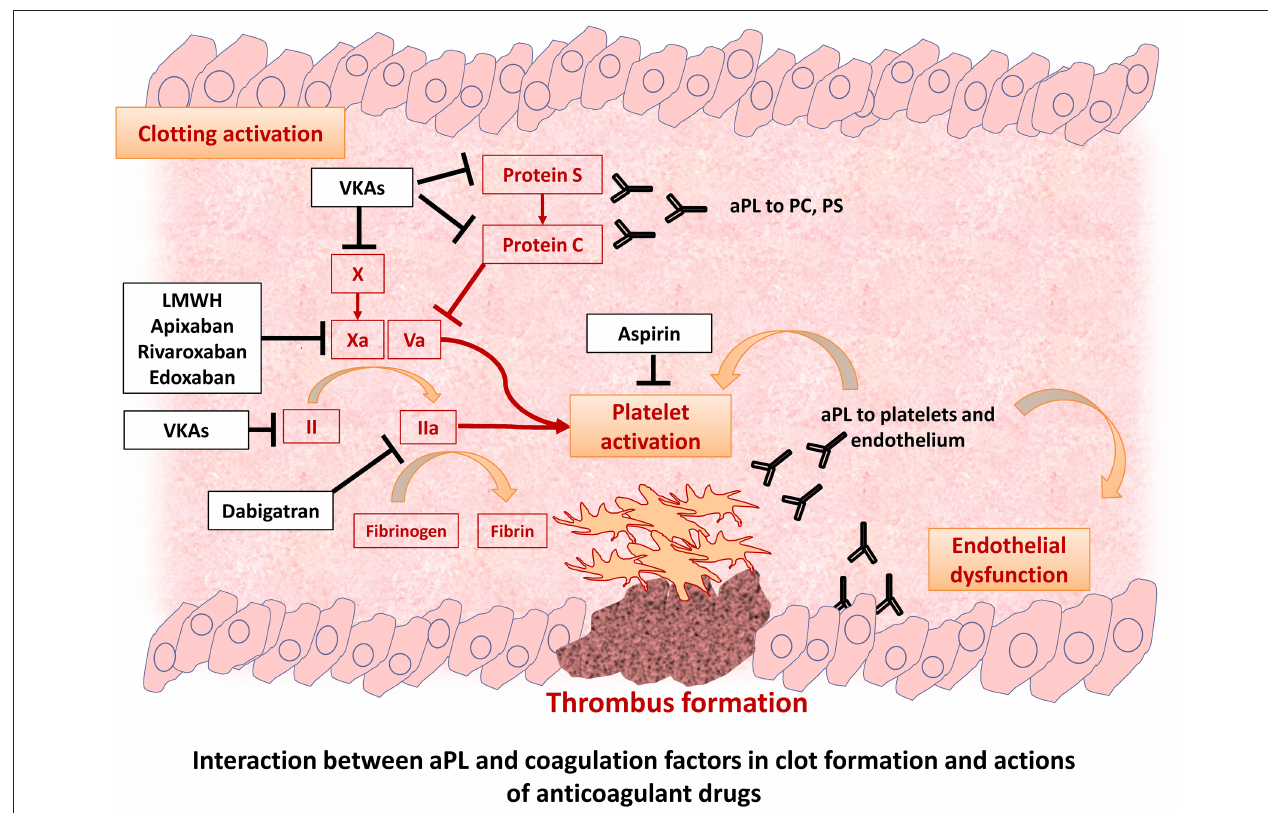
FIGURE 1 | Pathophysiology of thrombotic events in patients with antiphospholipid